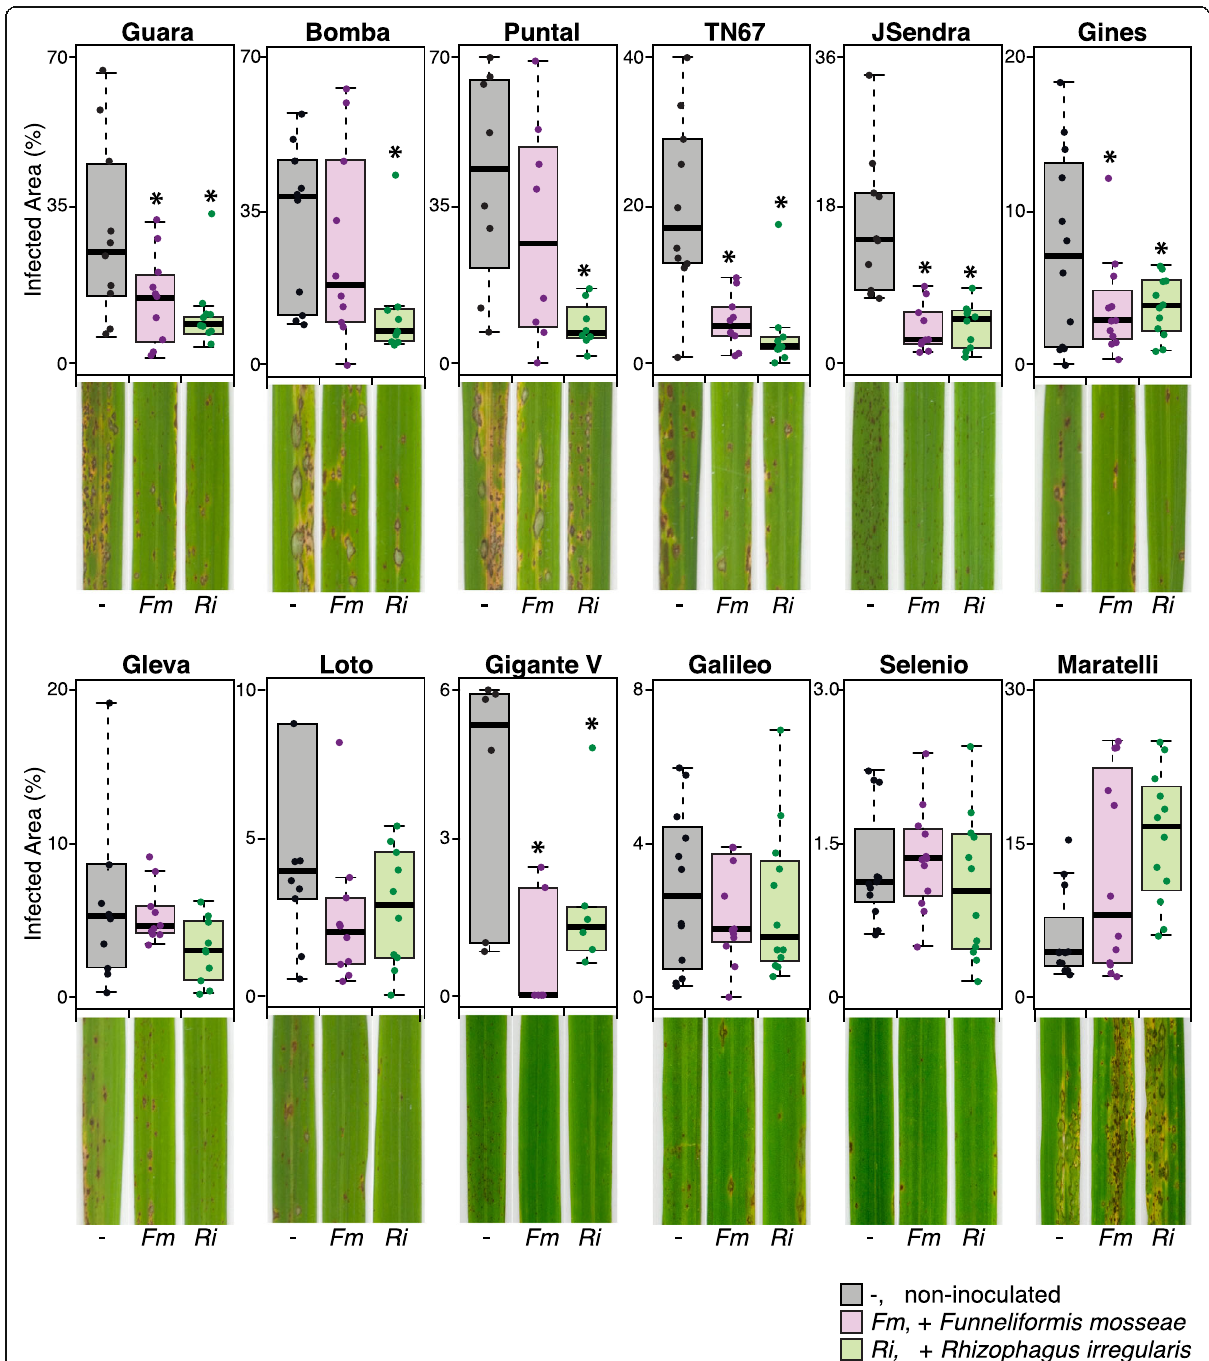
Fig. 5 Resistance to M. oryzae infection of AM-inoculated rice. Rice seedlings (one-week-old) were inoculated with an AM fungus: F. mosseae or R. irregularis . Three weeks later, the rice seedlings were infected with M. oryzae spores (see Additional file 3: Figure S3 for the experimental design). Pictures show blast symptoms in each variety at the following times after M. oryzae infection: 4 dpi, Loto and Guara; 5 dpi, Puntal, TN67, Gleva and Maratelli; 6 dpi, JSendra, Gigante Vercelli, Gines, Galileo and Bomba, and 7dpi, Selenio. Three independent experiments were carried out with similar results. Box plots represent the percentage of leaf area affected by blast lesions as determined by image analysis. Values obtained for each biological replicate were plotted ( n = 10). Error bars represent the first and third quartiles. The horizontal line within the box represents the median value (i.e., 50th percentile). Asterisks denote statistical differences (* p < 0.05, ANOVA test). Outliers are included. Representative images of M. oryzae -infected leaves from mycorrhizal and non-mycorrhizal plants are